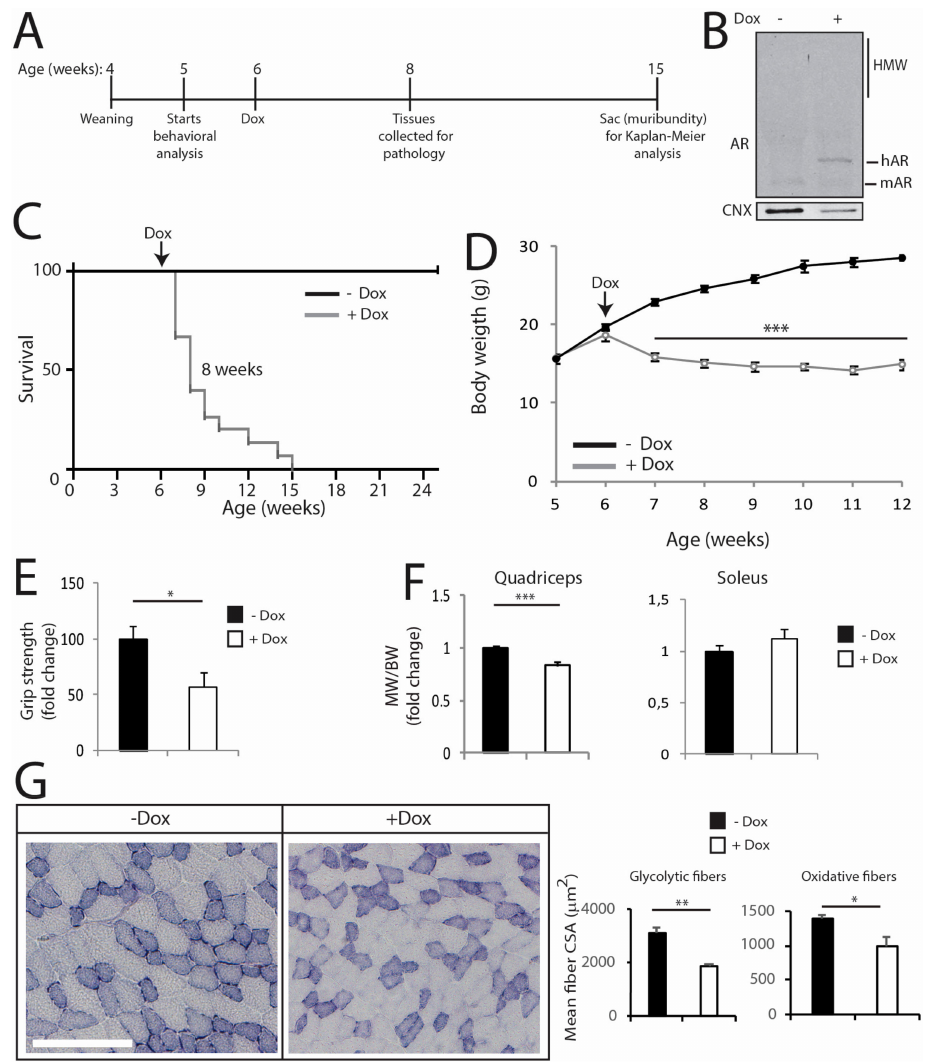
Figure 8. Induction of polyQ-expanded AR expression in the adulthood is su ffi cient to cause several, but not all disease manifestations in mouse. ( A ) Scheme of treatment of conditional SBMA mice with doxycycline (dox). ( B ) Western blotting analysis of AR expression in the quadriceps of 8-week-old iAR100Q / rtTA male mice treated with either vehicle ( − ) or dox ( + ). Shown is one experiment representative of three. ( C ) Kaplan-Meier analysis of survival of iAR100Q / rtTA male mice treated with either vehicle ( n = 8) or dox ( n = 15). Survival curves were compared using Log-rank (Mantel-Cox) test. ( D ) Temporal changes in mean BW of iAR100Q / rtTA male mice treated with either vehicle ( n = 8) or dox ( n = 15). ( E ) Grip strength analysis of muscle force of 8-week-old iAR100Q / rtTA male mice treated with either vehicle ( n = 8) or dox ( n = 8). ( F ) MW normalized to BW in 8-week-old iAR100Q / rtTA male mice treated with either vehicle ( n = 4) or dox ( n = 5). ( G ) Analysis of the mean CSA of fibers in the TA of 8-week-old iAR100Q / rtTA male mice ( n = 3–4) treated with either vehicle or dox. Number of fibers: 1600 fibers vehicle, 1200 dox. Graphs, mean ± SEM. Statistical testing: ( D ) Mann-Whitney test for each time point; ( E – G ) Student’s t test; * p < 0.05, *** p <